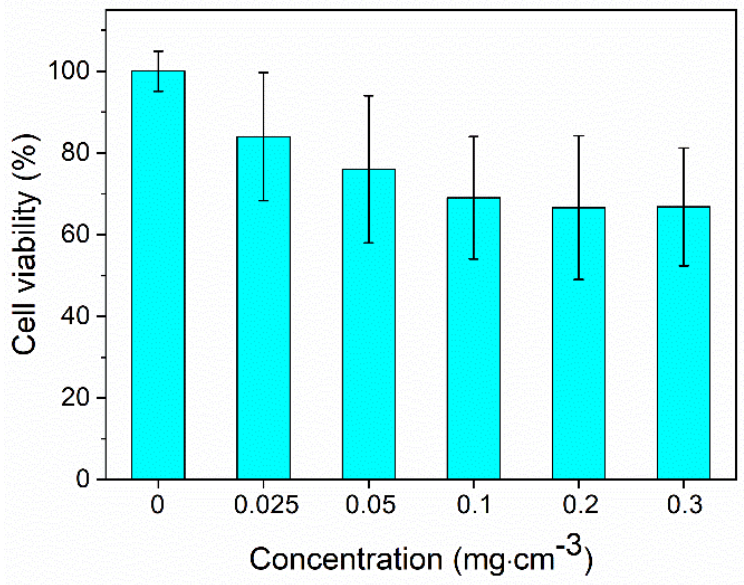
Figure 10. Cell viability of the Nd (1.5%):LuVO 4 nanoparticles functionalized with PAA.